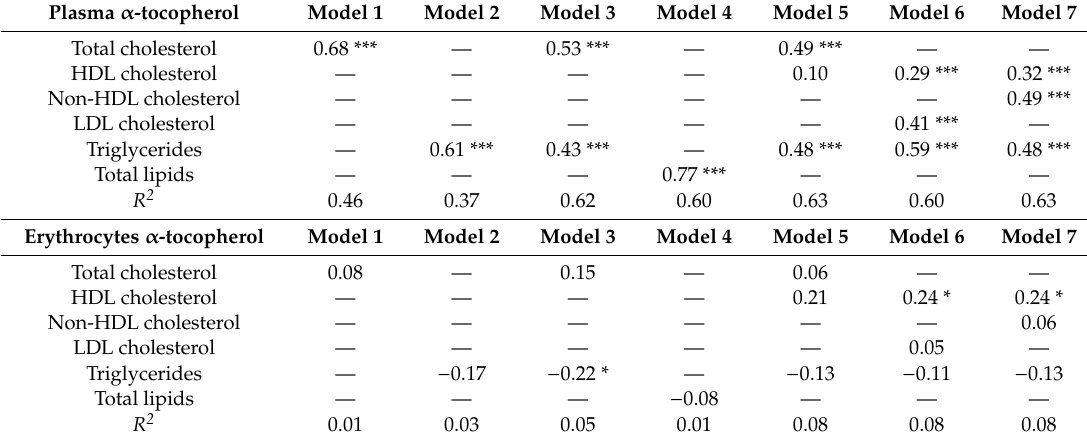
Table 1. Association between plasma and erythrocytes α -tocopherol and fasting lipids in renal transplant recipients ( n =